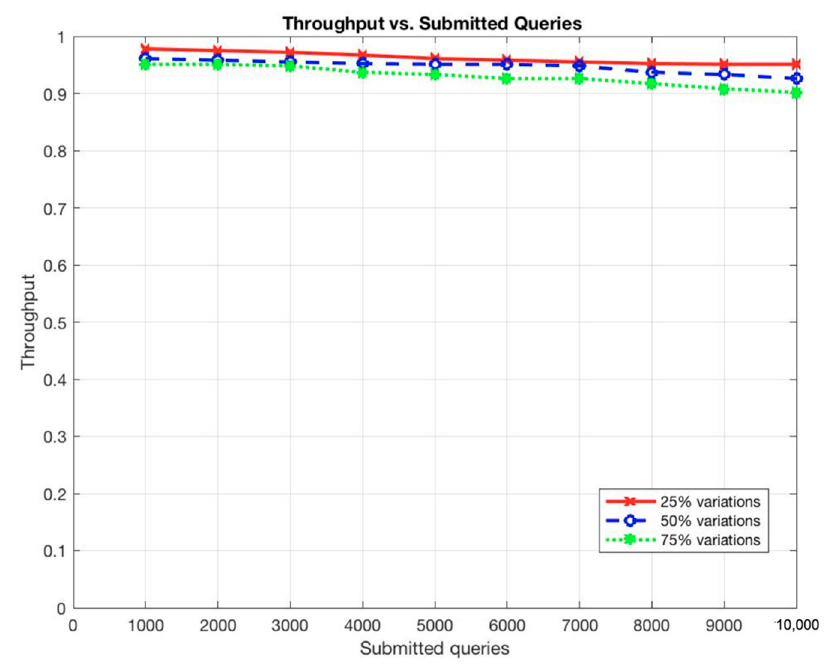
Figure 11. Throughput vs. Submitted queries.